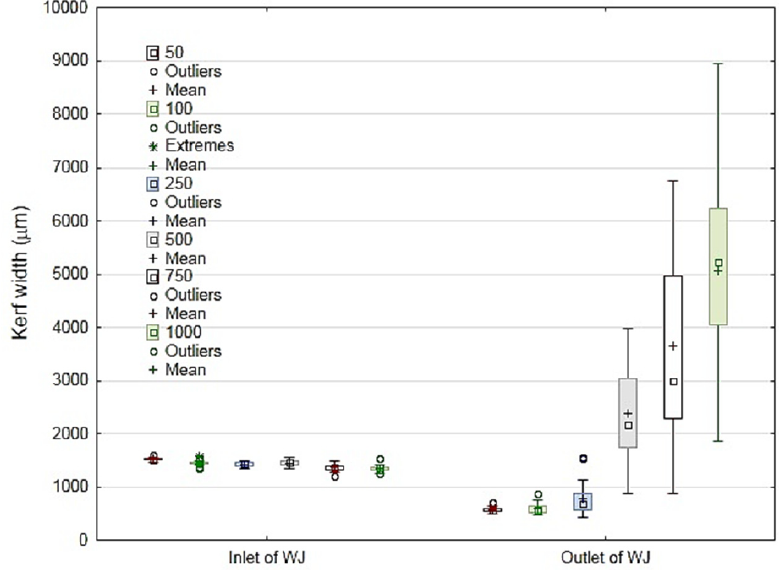
Figure 7. Kerf width of cut without abrasive grains, at the inlet and outlet of cutting zone [55].